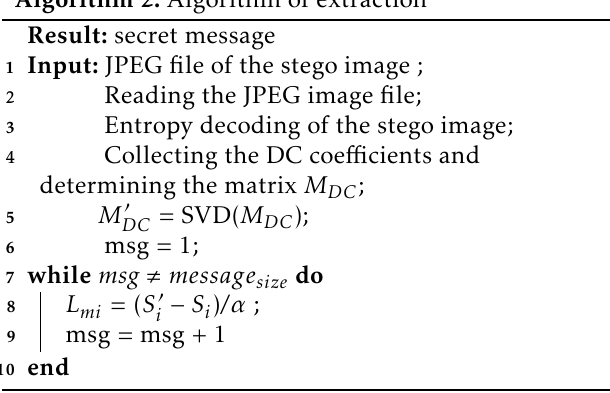
Algorithm 2: Algorithm of